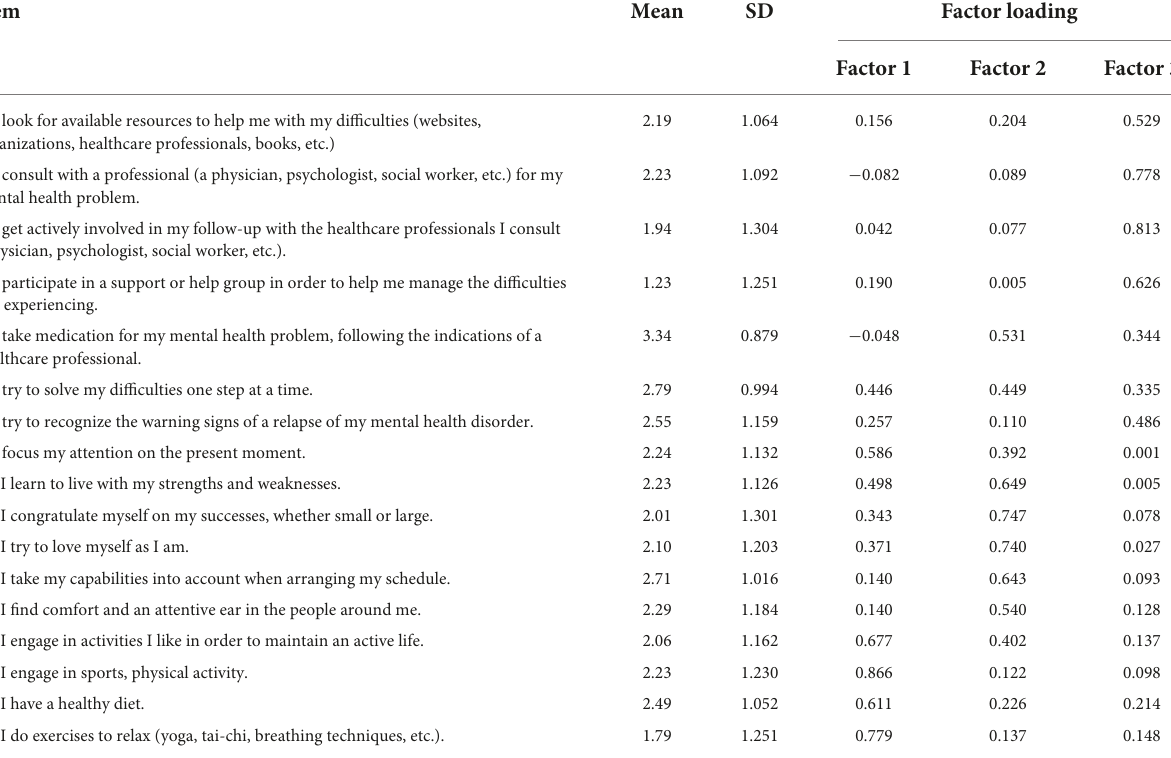
TABLE 4 Factor analysis and mean scores of the